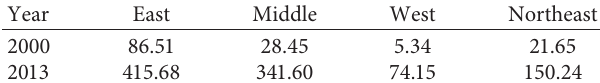
Table 6: Highway density in different regions of China.